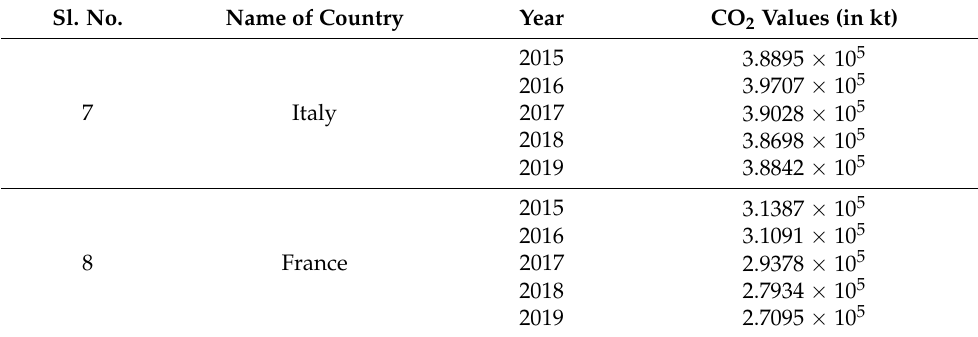
Table 5. Cont . Sl.